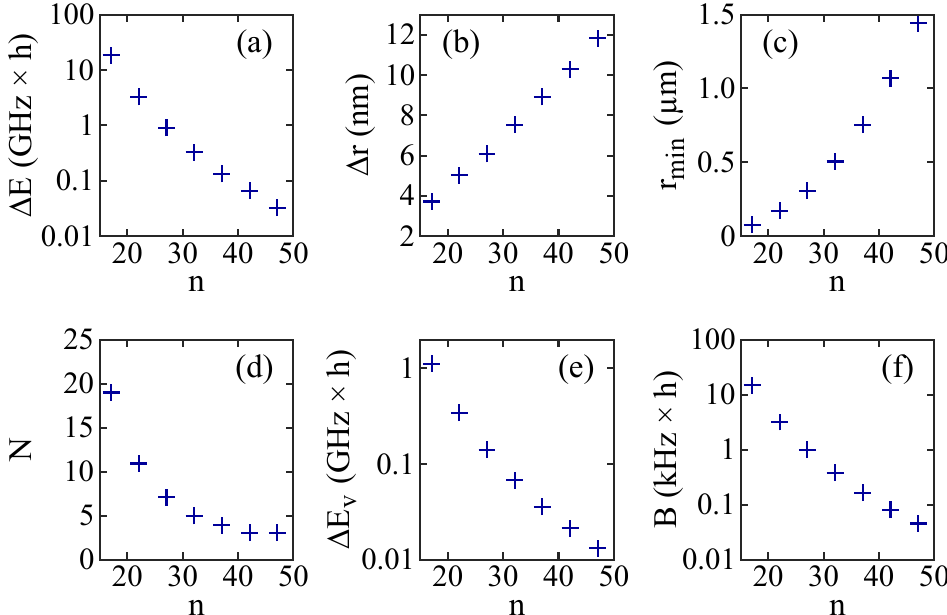
Figure 2. Properties of the second outermost potential wells associated with the nP 1/2 states of Rb and of corresponding molecular bound states as functions of the principal quantum number n . ( a ) Depth ∆ E (on a logarithmic scale). ( b ) Width ∆ r . ( c ) Position r min . ( d ) Number N of vibrational bound states. ( e ) Energy splitting ∆ E v between the vibrational ground state and the first excited vibrational state (on a logarithmic scale). ( f ) Rotational constant B for a 87 Rb 138 Ba + molecule (on a logarithmic